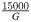
Differences in payoff rates.The population average difference in rate of fitness payoff between the preferred action and the beneficial action, as a function of group size G. (a) Subjective rewards are unbiased (α = 1). (b) After the inflation factor α has evolved for 10000 generations. The three cases shown are: Hawk-Dove game (open squares), Resource Exploitation game (filled circles) and Producer-Scrounger game (open triangles). For the latter game, the cases G = 3, 4 are not shown as no equilibrium configuration exists. For each value of G, a group of 15000 individuals is divided into 15000G groups of size G. Game parameter values as for Fig 1.